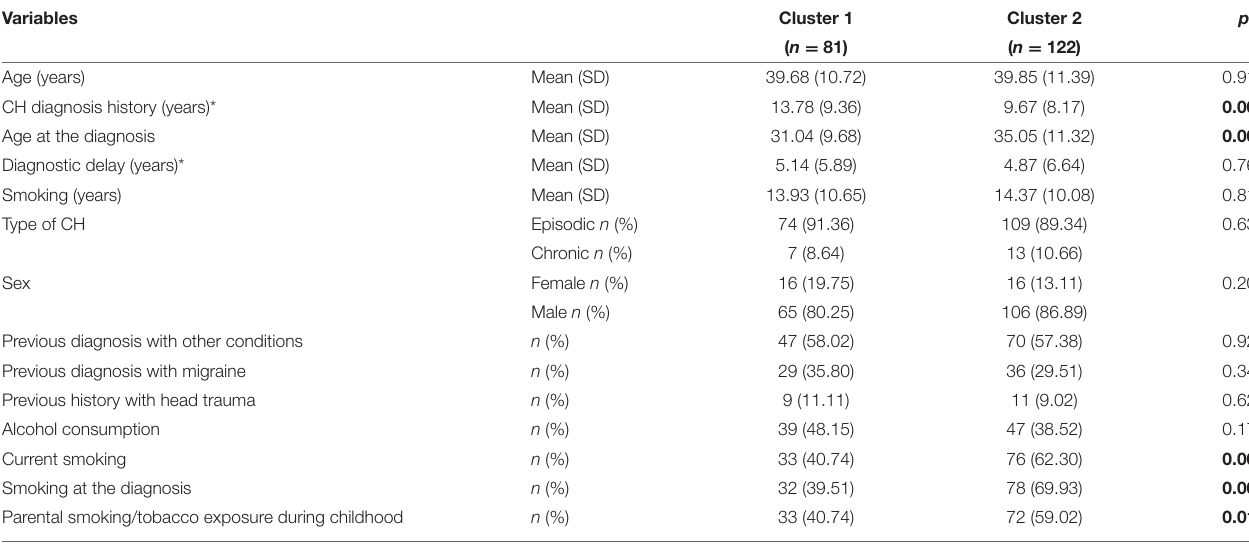
TABLE 1 | Demographic characteristics of the patients in cluster